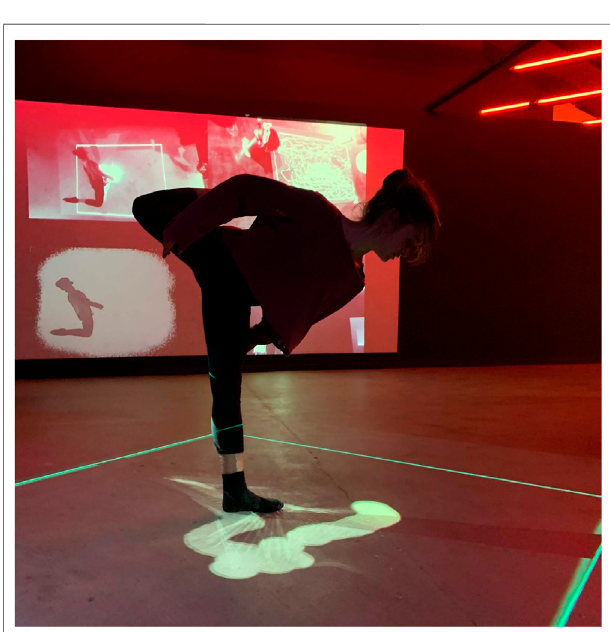
FIGURE 14 | The artist performs If/Then performance at the museum. The four channel projections on one wall of the gallery were comprised of four real time cameras that alternated throughout, giving the audience a chance to observetheperformancefromvarious perspectives. Thevideochannels were VJ ’ ed live by Pekarik. Jochum designed and operated the lights, and Gomez performed live mixing of the real-time sound